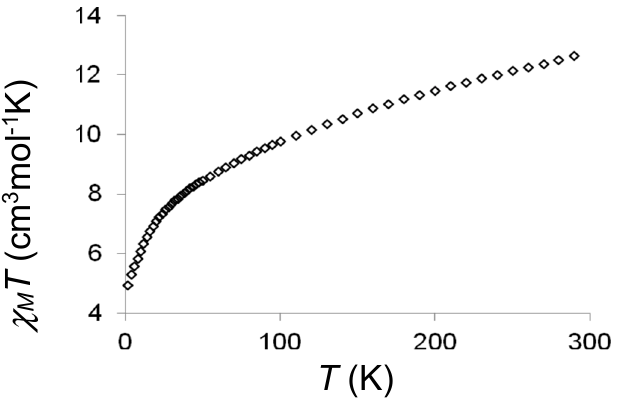
Figure 11. Temperature dependence of the χ M T product for complex 5 at an applied magnetic field of 0.1 T.